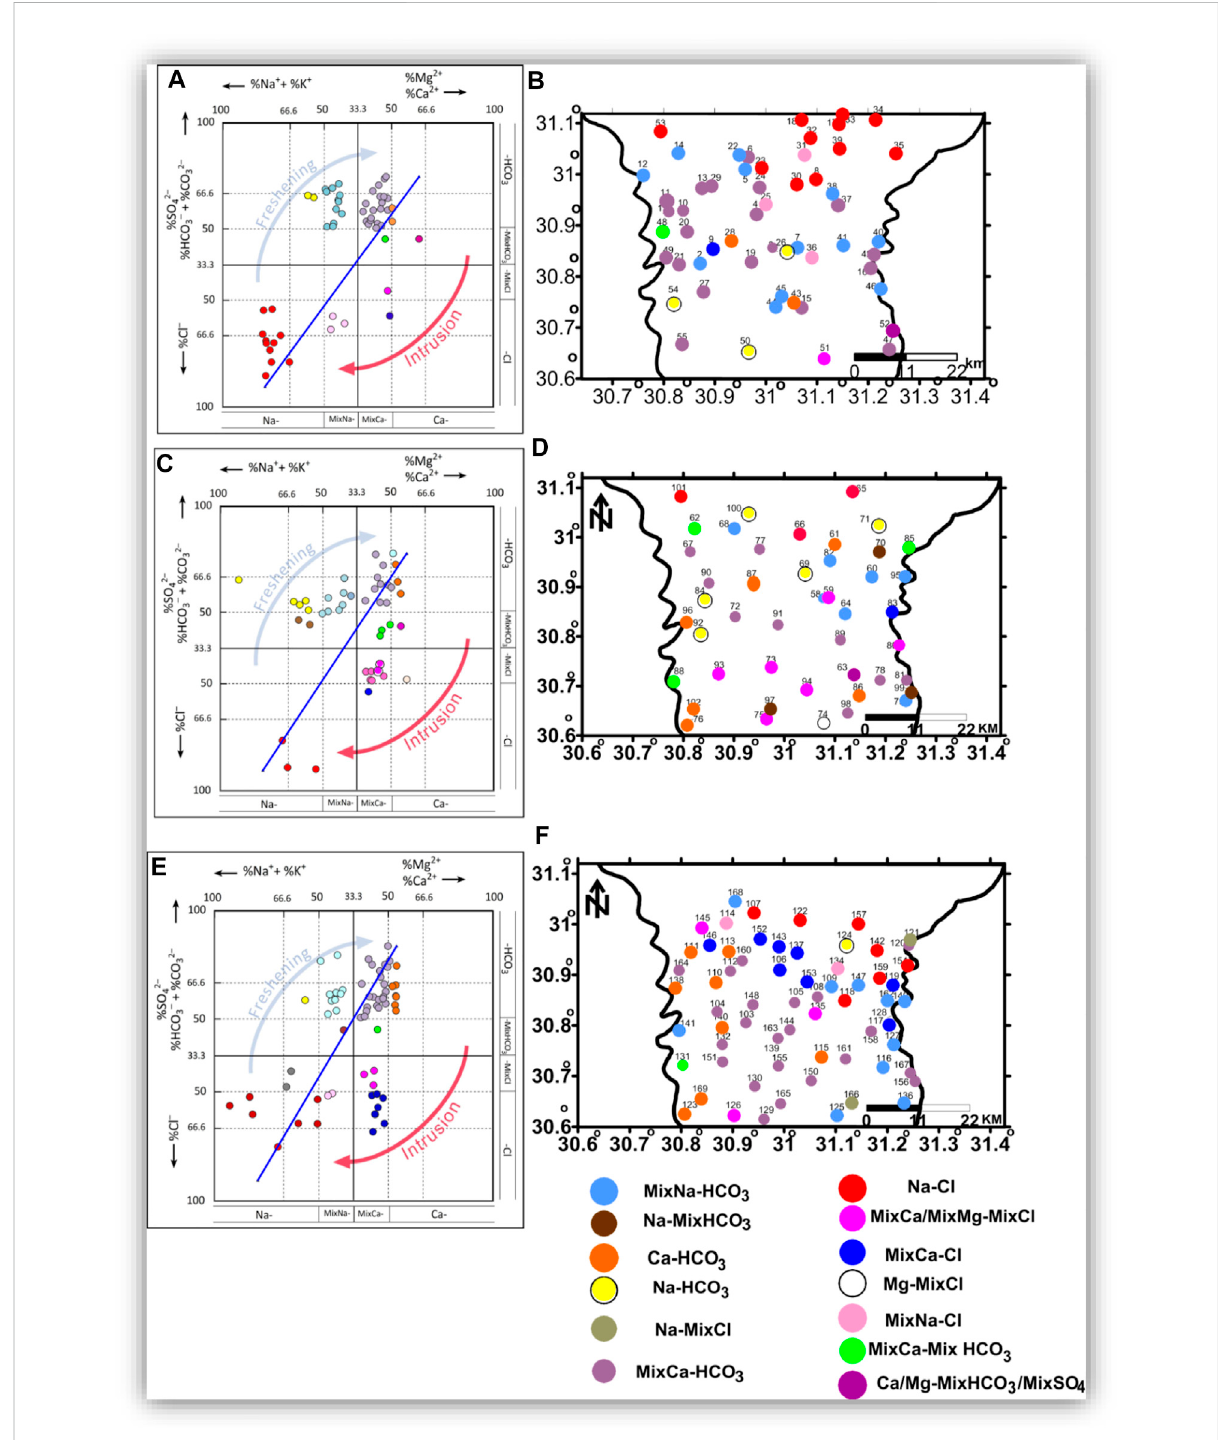
FIGURE 23 The HFE-diagrams (A,C,E) and facies spatial distribution in the shallow zone (B) , intermediate zone (D), and deep zone (F)